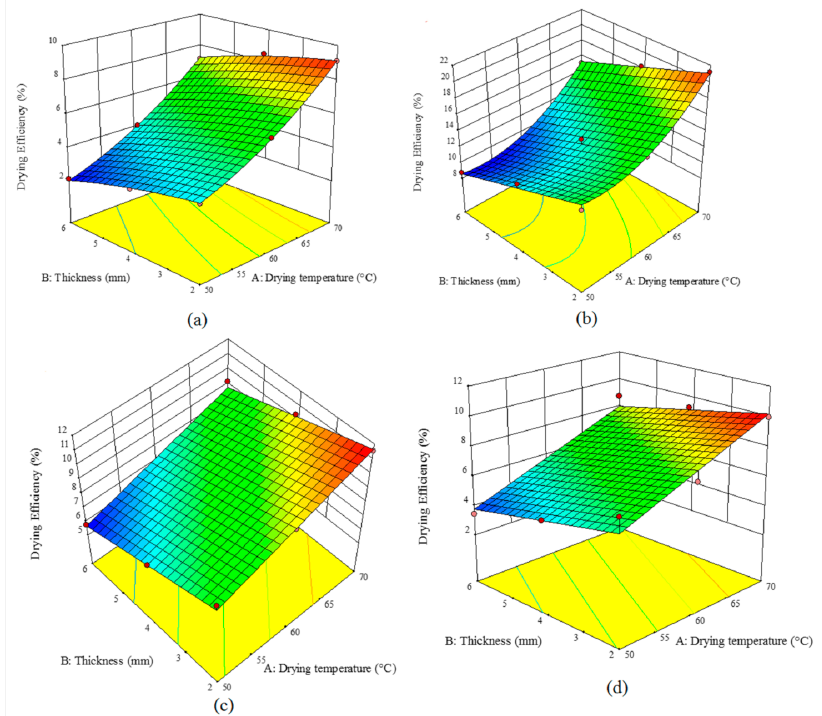
Figure 5. Effect of the drying temperature and sample thickness on the drying efficiency (%) of an HCIR dryer with various pretreatments ( a ) control, ( b ) microwave, ( c ) ultrasound, and ( d )